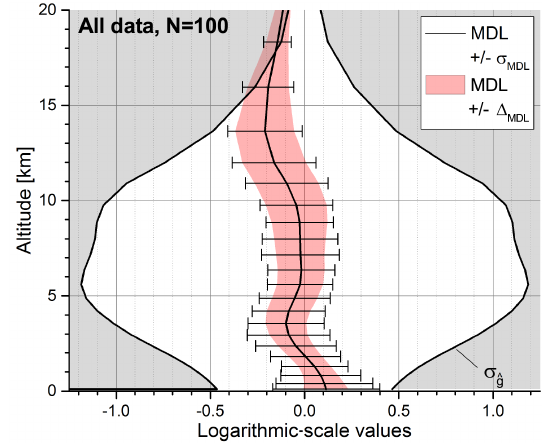
Figure 13. Same as Fig. 12, but considering all four ensembles as a single data